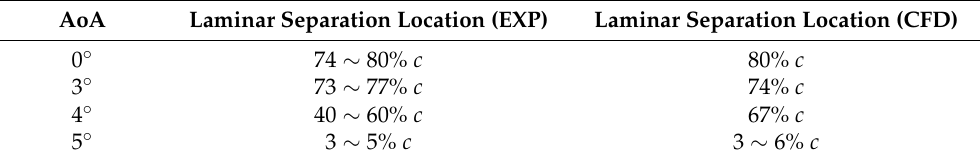
Table 7. Predicted laminar separation location and comparison to experiments, Re = 300,000.